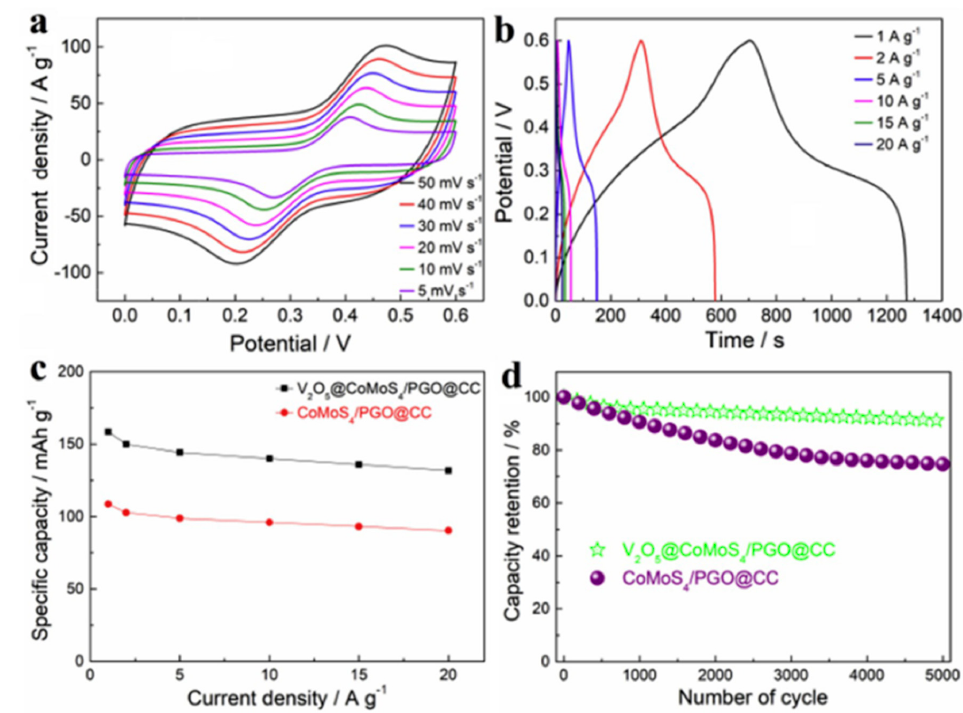
Figure 6. ( a ) CV and ( b ) GCD curves of V 2 O 5 /CoMoS 4 /CC/graphene at different scan rates and cur- rent densities, respectively. ( c ) C sp values of V 2 O 5 /CoMoS 4 /CC/graphene and CoMoS 4 /CC/graphene at different current densities and ( d ) cycling performances of V 2 O 5 /CoMoS 4 /CC/graphene and CoMoS 4 /CC/graphene. Reprinted with permission from Ref. [109]. Copyright 2020